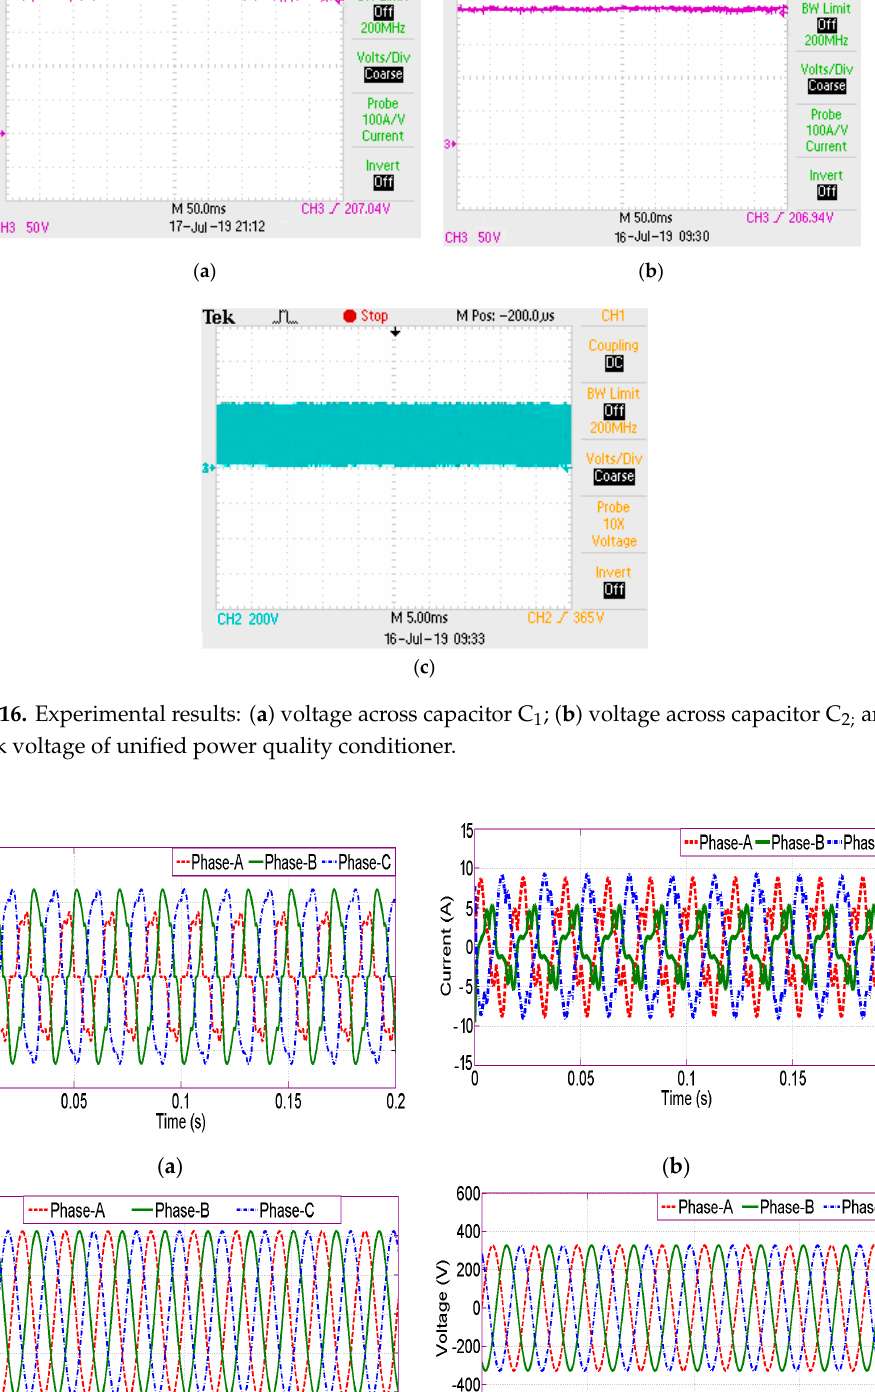
( b ) Figure 18. Simulation results under balanced voltages with unbalanced load: (a) THD level of load current before compensation; (b) THD level of source current after compensation. Figure 19 shows the experimental results of supply voltage, load current, and harmonic load current distortions before QZSI-based UPQC was connected. Injected voltage, load voltage, and injected current and source current after connecting QZSI-UPQC is shown in Figure 20. After connecting QZSI-UPQC support to the SPV, THD source current levels decreased to a tolerable level. The experimental results show that a control approach was implemented in the three-phase four-wire electric power systems, which decreased the harmonic elements and voltage distortion.